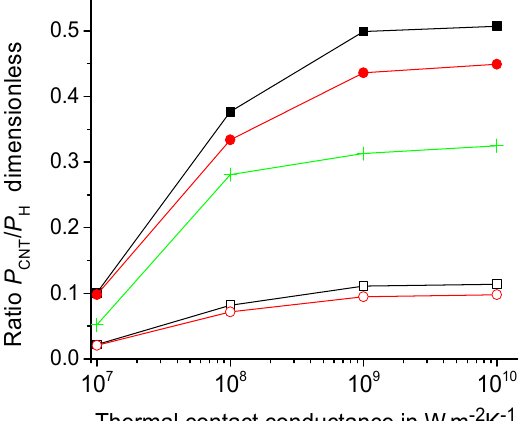
Figure 9. Ratio P CNT / P H vs. G C at R C = 20 nm and 50 nm, represented by the filled and open symbols, respectively, for λ CNT = 10 3 W · m − 1 K and 10 2 W · m − 1 K (the squares and circles, respectively) at 𝑅 (cid:2869) = 10 nm as well as at 𝑅 (cid:2869) = 5 nm for 𝑅 (cid:3004) = 20 nm and 𝜆 (cid:3004)(cid:3015)(cid:3021) = 10 3 W·m (cid:2879)(cid:2869) 𝐾 (cid:2879)(cid:2869) (the crosses).